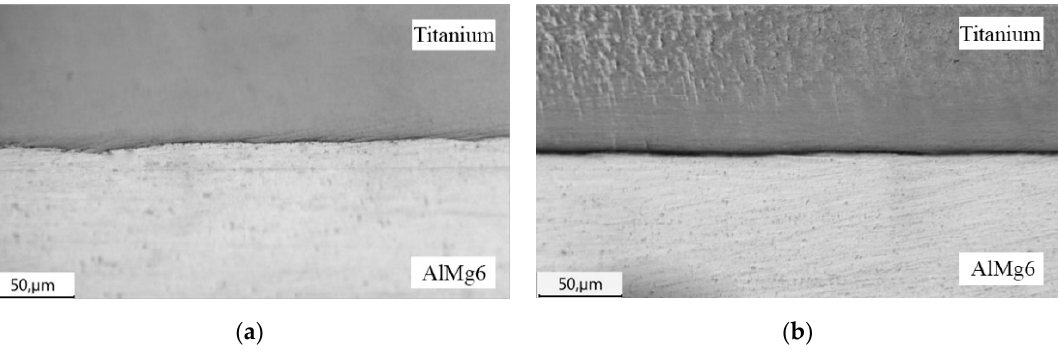
Figure 5. SEM micrographs: ( a ) the weld interface beside the welding point; ( b ) the weld interface of the other edge of the bimetal.